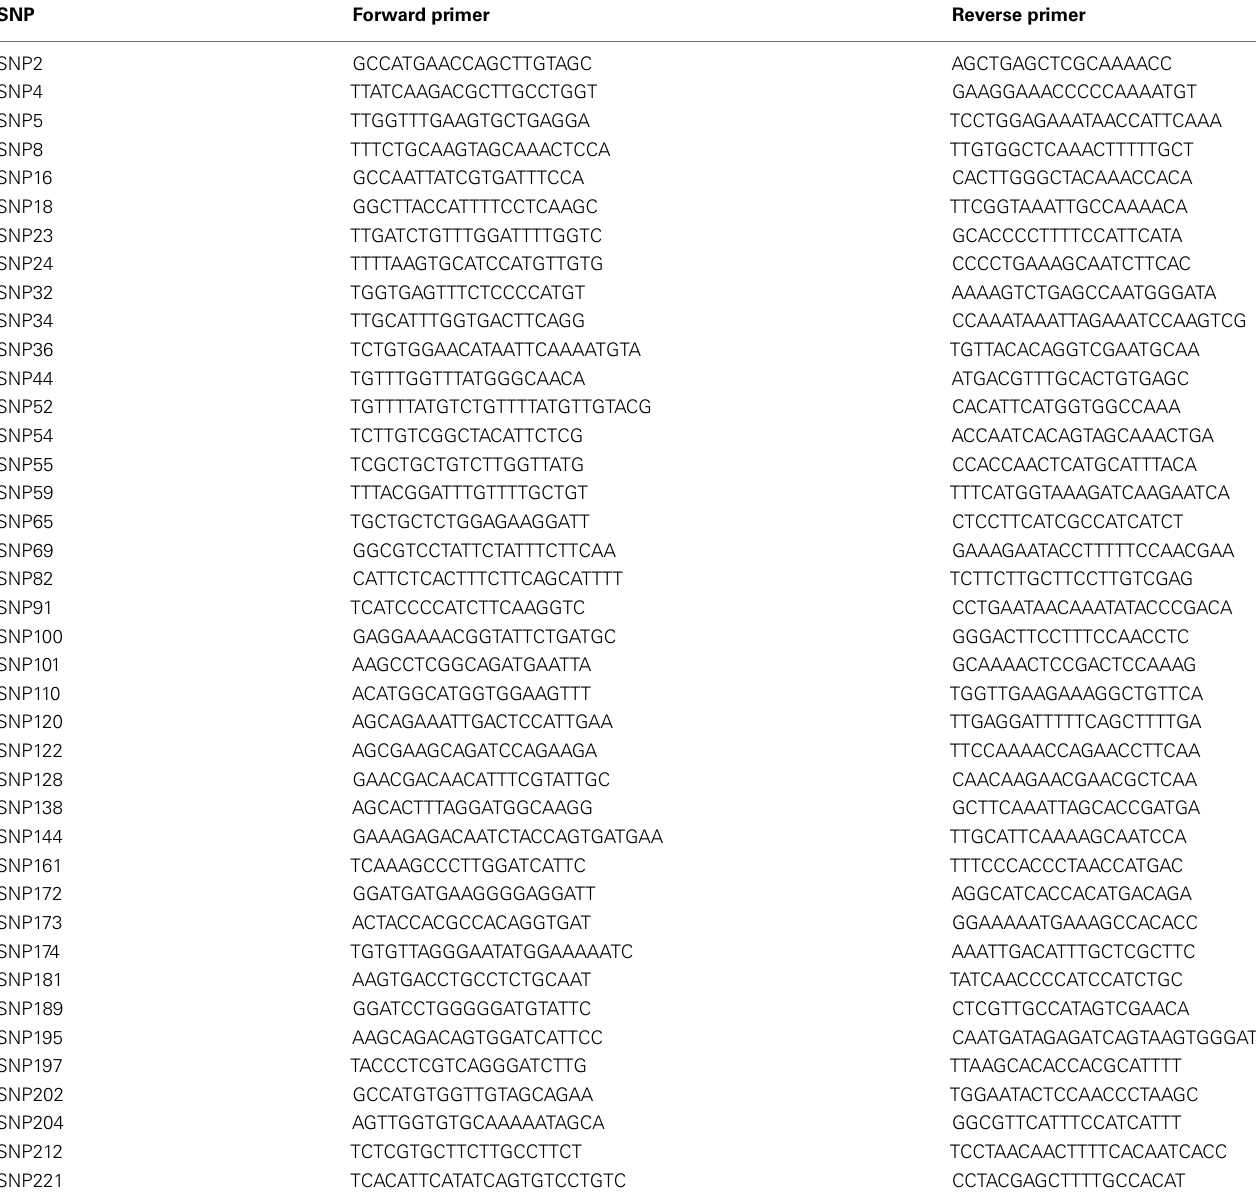
Table 2 | SNP primers used and their forward and reverse